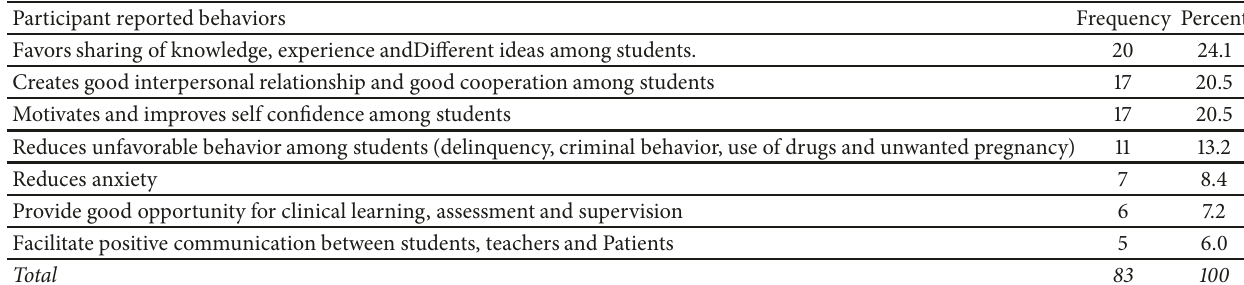
Table 9: Effects of good social environment on clinical practice (n=83).